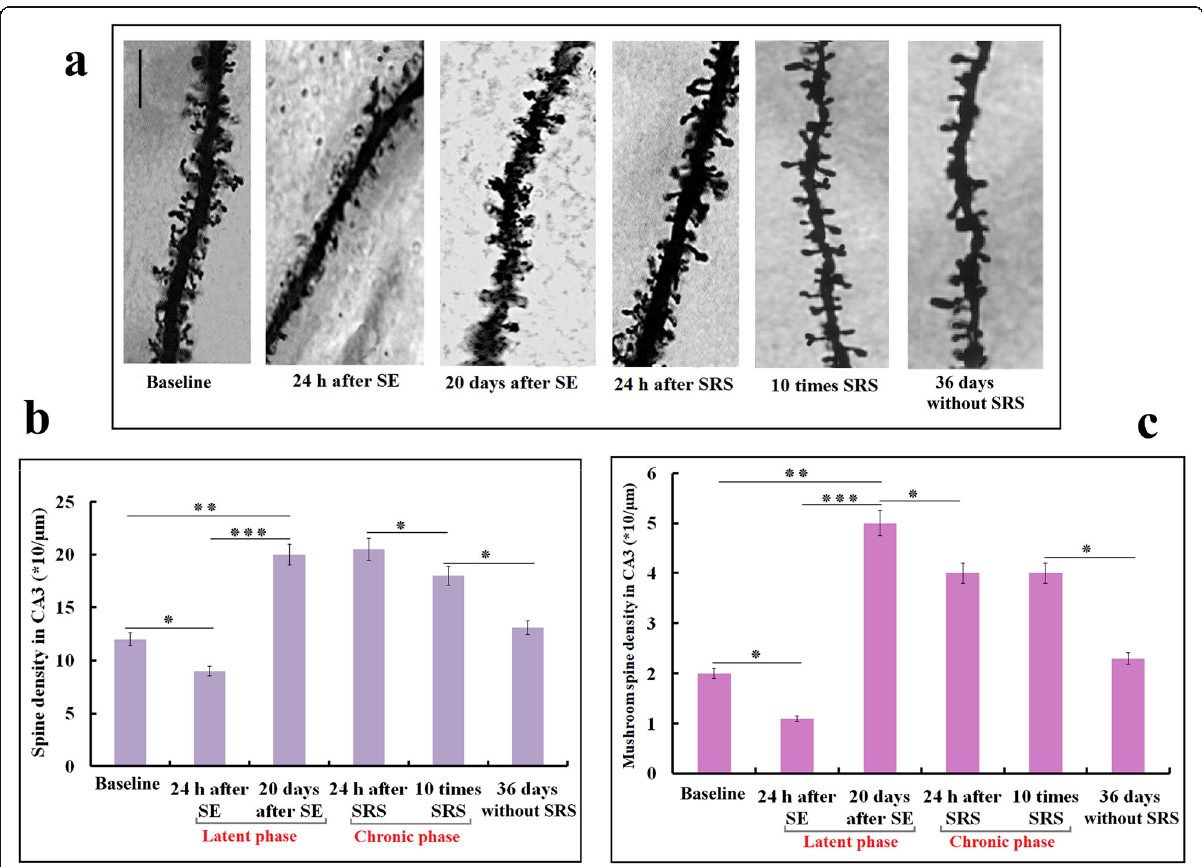
Fig. 5 Spine density and number of mushroom-type spines in epileptic rats. a Spines observed at 40× magnification in the CA3 region. Scale bar represents 5 μ m. b Quantification of spines per μ m of dendrites length. The amount of spines increased during the epileptogenesis, and then decreased after 10 times of SRS. c Quantification of mushroom spines. Data are presented as mean ± SEM. * P < 0.05, ** P < 0.01 and *** P <